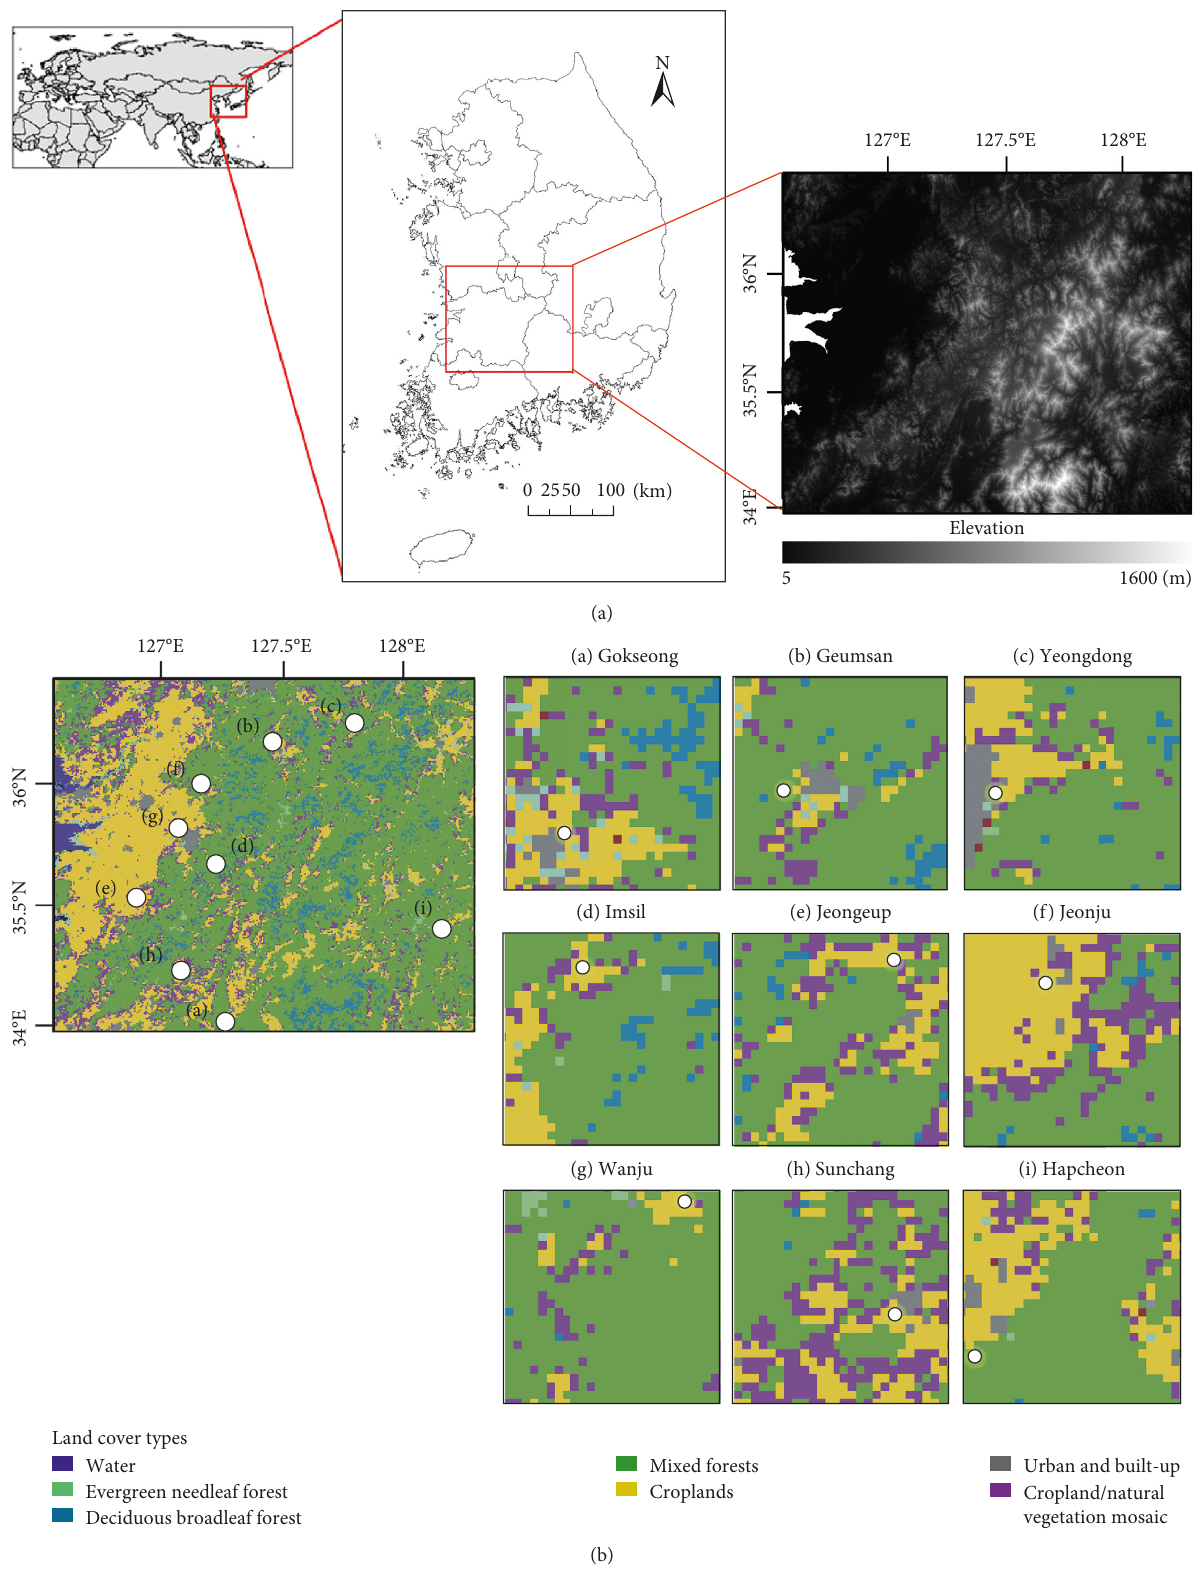
Figure 1: (a) Study area on the Korean Peninsula and (b) the in situ sites (white